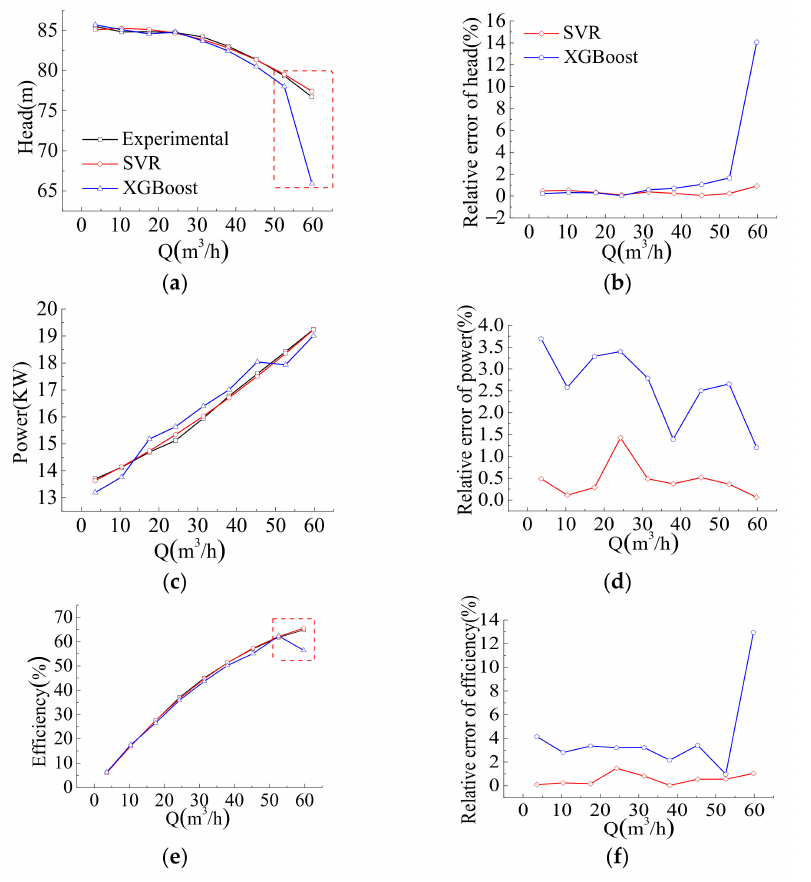
Figure 9. Comparison of performance prediction models for single-stage single-suction centrifugal pumps with a specific speed of 46.2. ( a – c ) are the predictions of head, power and efficiency; ( d – f ) are the absolute relative error of head, power and